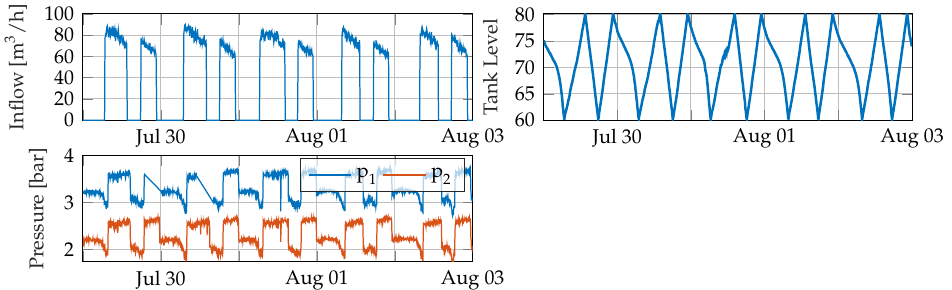
Figure 14. Graphs of real data collected by Bjerringbro ´ s water utility. The measurement nodes are represented in Figure 12 and the tank filling is regulated with a standard ON/OFF control.